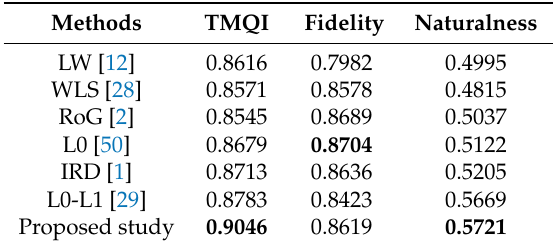
Table 2. TMQI evaluation of the compared